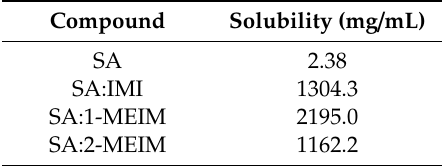
Table 3. Preliminary solubility results obtained for SA, SA:IMI, SA:1-MEIM and